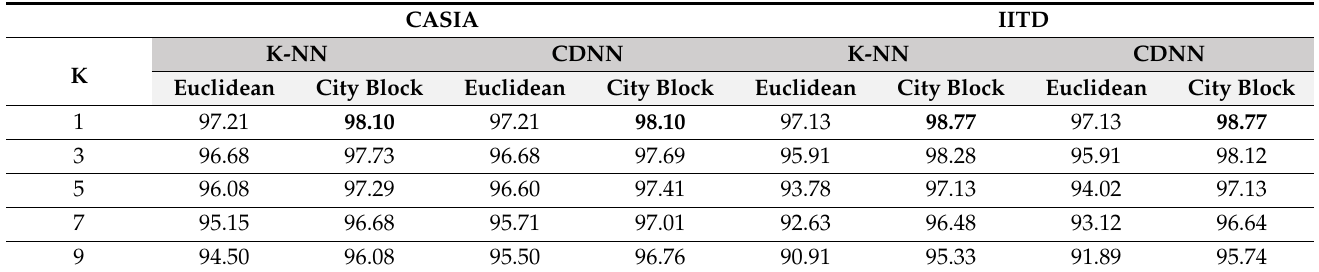
Table 7. The performance of our system using K-NN vs. CDNN applied to IITD and CASIA databases. CASIA IITD K-NN CDNN K-NN CDNN